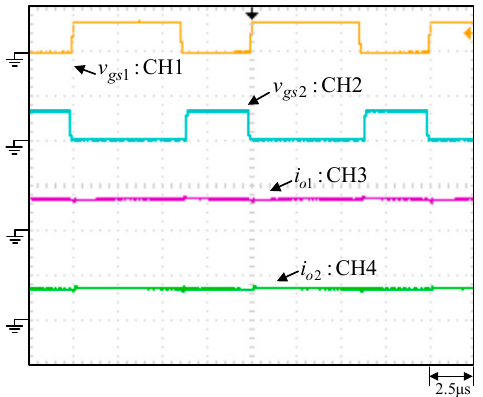
Figure 21. Waveforms at input voltage of 3.3 V [14]: (1) v gs 1 (20 V/div); (2) v gs 2 (20 V/div); (3) i o 1 (500 mA/div); (4) i o 2 (500 mA/div).